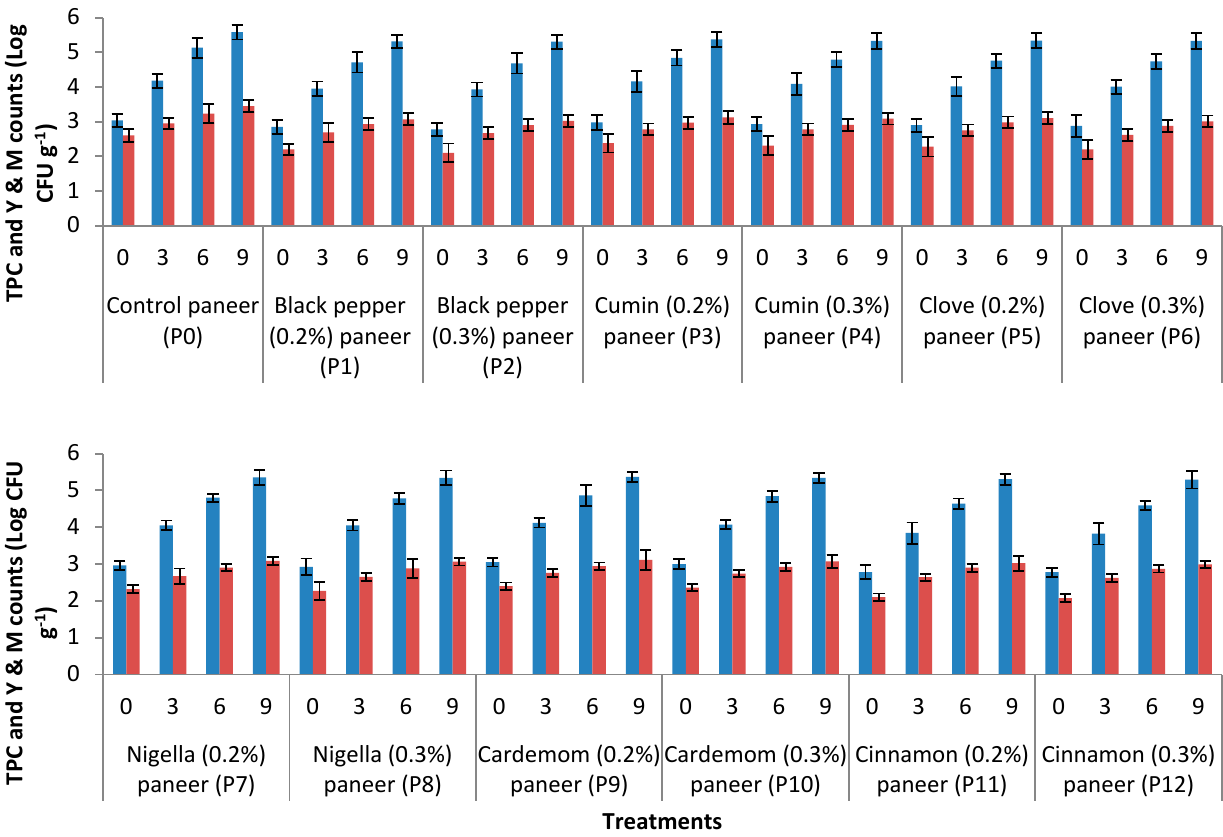
Figure 1. TPC (means ± SD, blue bars) and Y & M (means ± SD, red bars) of spicy paneer during storage at 5 °C.